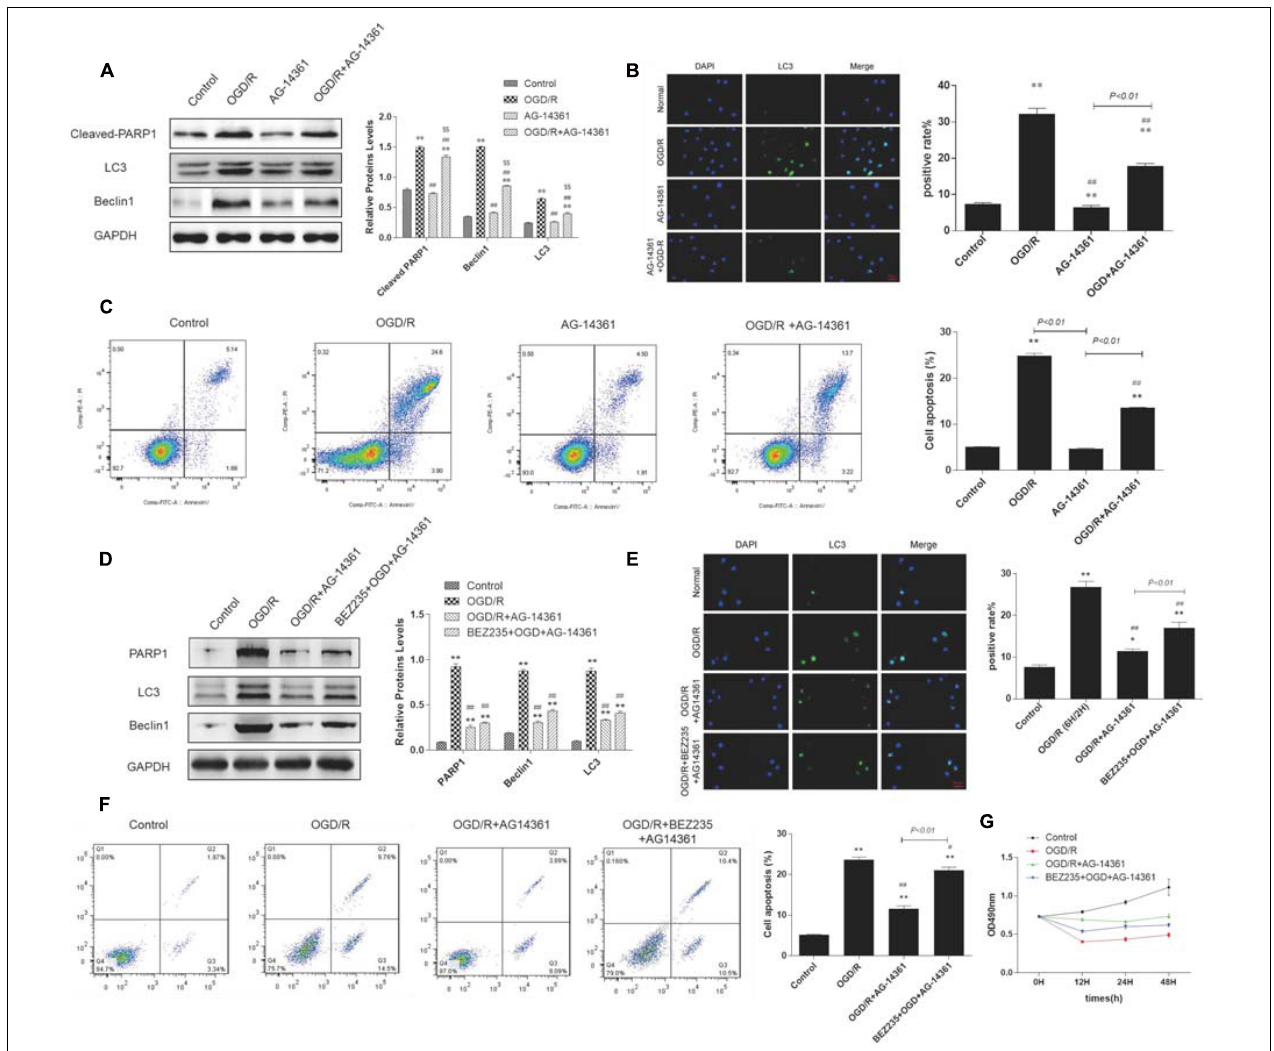
FIGURE 2 | PARP1 inhibition protected cardiomyocytes from OGD/R through inhibition of autophagy. The OGD/R-modeled H9c2 cells were treated with PARP1 inhibitor AG-14361 (10 µ M) for 1 h and a novel autophagy promoter NVP-BEZ235 (0.25 µ M) for 24 h. (A) Western blot showed the expression of PARP1 and autophagy related proteins rose when H9c2 cells were treated with AG-1436. (B) GFP-LC3 assay showed the different level of GFP puncta between control group and other groups. Magnification: 630 × . (C) Flow cytometry analysis assessed the apoptotic rate of control group and other groups. (D) Western blot assessed the expression of PARP1 and autophagy related proteins when H9c2 cells was treated with PARP1 inhibitor and BEZ235. (E) GFP-LC3 assay showed the different level of GFP puncta between control group and other groups. Magnification: 630 × . (F) Flow cytometry analysis showed the apoptotic rate of control group and other groups. (G) MTT assay showed the OD value of cells in control group and other groups. Compared with control group, * P < 0.05, ** P < 0.01; compared with OGD/R group, # P < 0.05, ## P < 0.01; Compared with AG-14361 group, $ P < 0.05, $$ P < 0.01. N = 4 for each